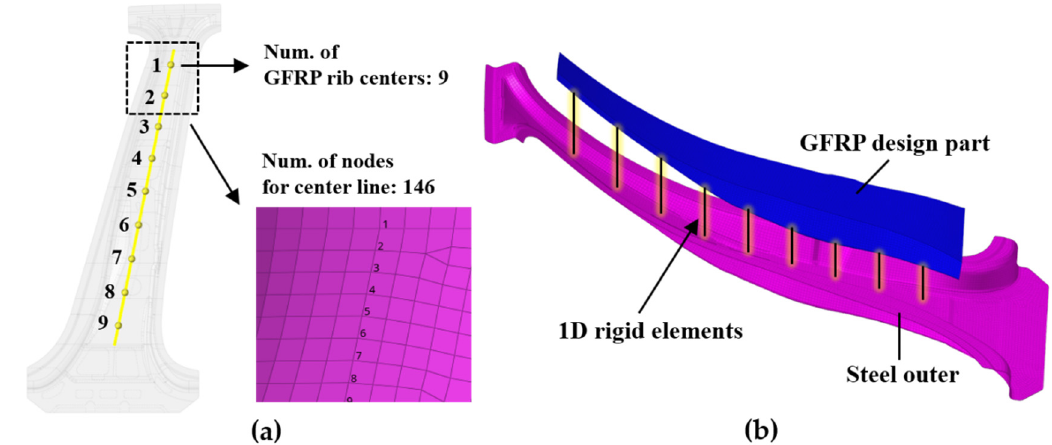
Figure 9. Analysis model concept for topology optimization of GFRP rib: ( a ) Definition of center line using nodes and ( b ) mechanical bonding points between steel outer part and GFRP design part.